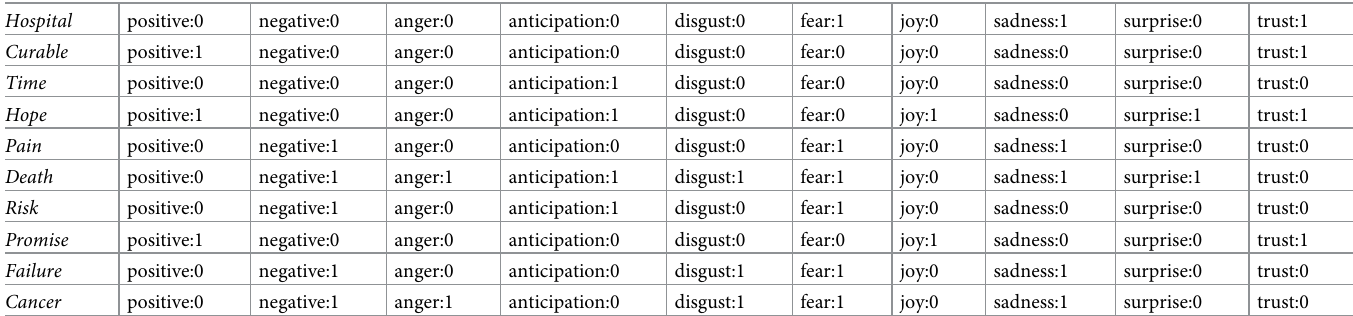
Table 1. Example of 10 words extracted from the NRC Lexicon.